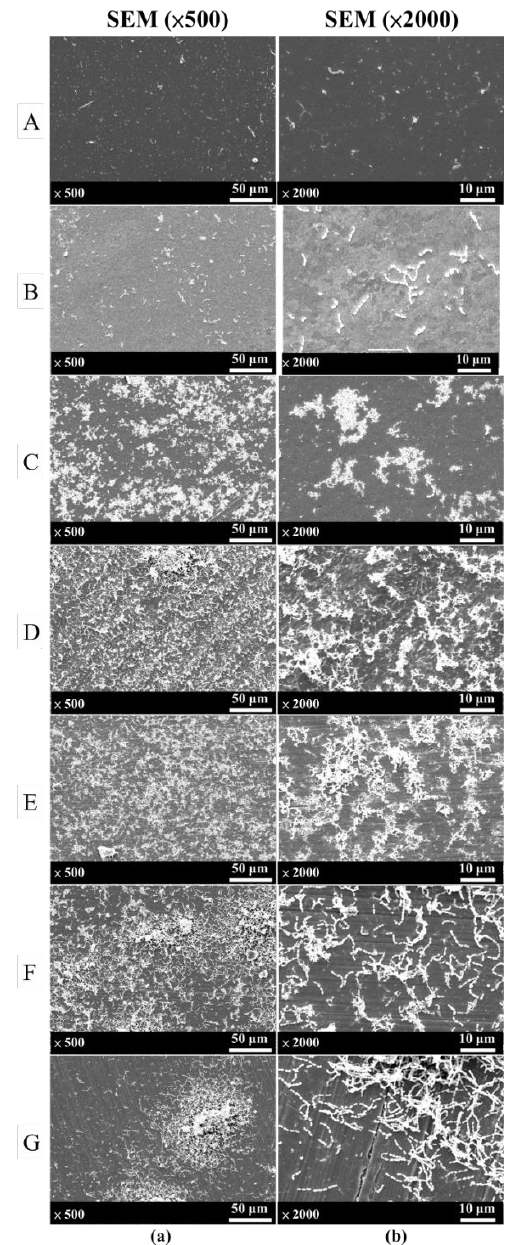
Figure 11. SEM micrograths taken from the Specimen A – G after biological test, showing that a